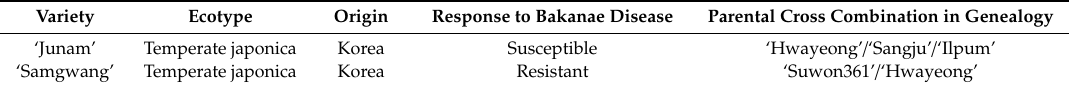
Table 4. Parental varieties used in this